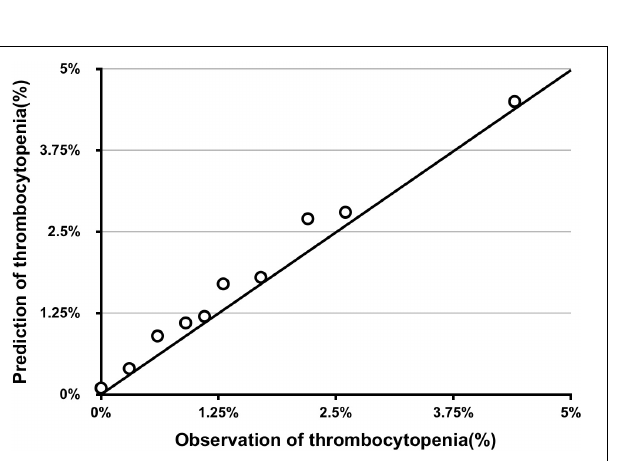
FIGURE 3 | Receiver Operating characteristics analysis—area under the curve according to risk score in the validation series.